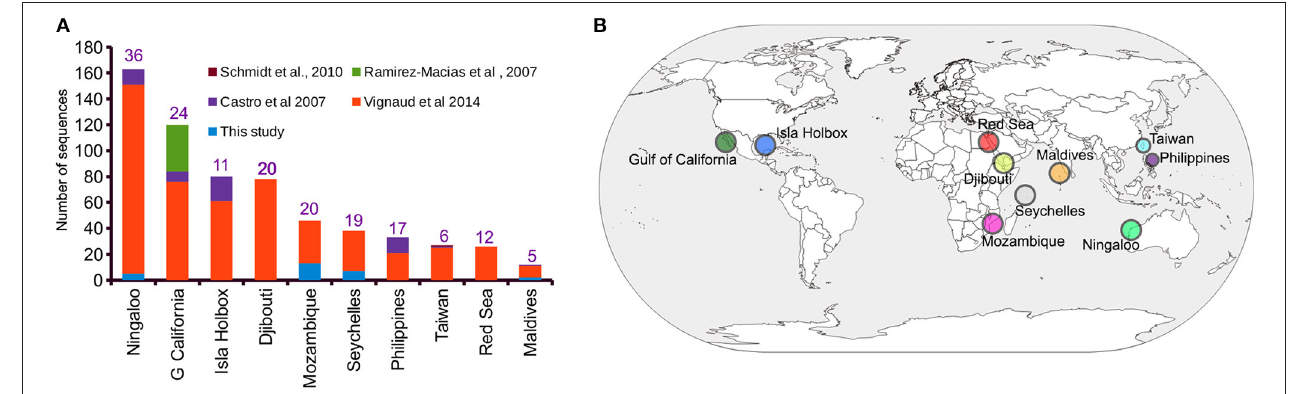
FIGURE 1 | Sampling distribution of Rhincodon typus based on the mitochondrial control region sequences. (A) A summary of the number of publicly available mitochondrial control region sequences of R. typus from different populations and studies. Numbers on each bar indicate the number of haplotypes that are present in each population. (B) An annotated world map showing the locations of R. typus sampled by all